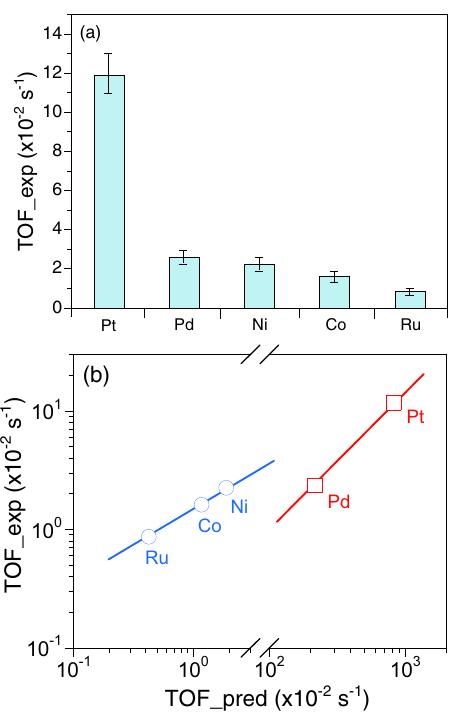
Fig. 2 2-octanol dehydrogenation over alumina-supported metal catalysts. a Experimental TOF and b predicted TOF vs. experimental TOF. Reaction conditions: T = 453 K, P = 101 kPa, p OL = 14 – 20 kPa, p H2 = 44 kPa, WHSV OL = 3.3 – 32 h − 1 . The catalysts were pre-reduced for 4 h at different temperatures according to the H 2 -TPR pro fi les (Supplementary Fig. 16): 453 K for Pd/Al 2 O 3 , 473 K for Pt/Al 2 O 3 and Ru/Al 2 O 3 , 723 K for Co/Al 2 O 3 , 773 K for Ni/Al 2 O 3 . The error bars in ( a ) refer to con fi dence intervals including error propagation.